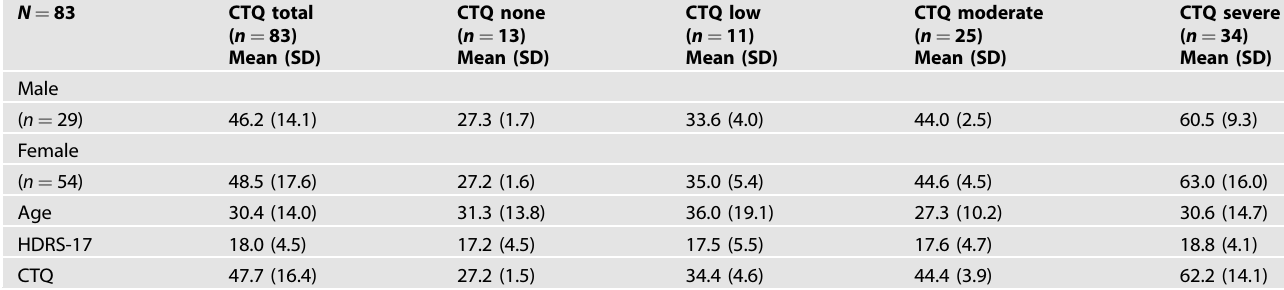
Table 2. Means and standard deviations (SD) of demographic and clinical characteristics by discrete categories of childhood trauma (childhood trauma) as de fi ned in Table